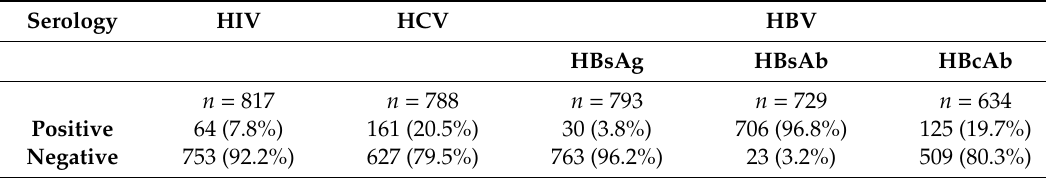
Table 5. Overall results of serological analysis among inmates ( n =